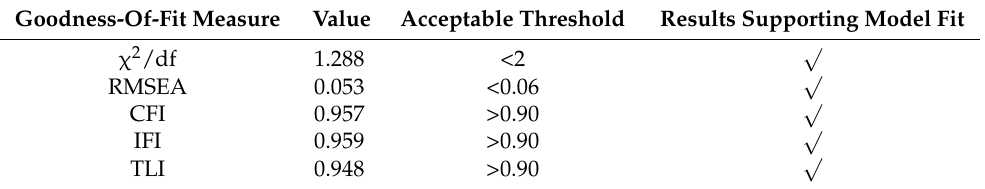
Table 4. Fit indices for the proposed measurement model and their acceptable threshold.